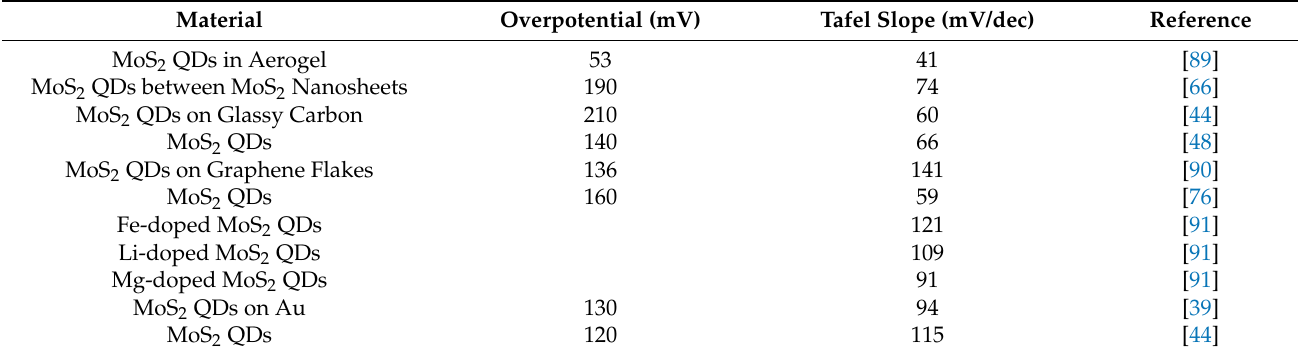
Table 3. Use of MoS 2 QDs in HER.